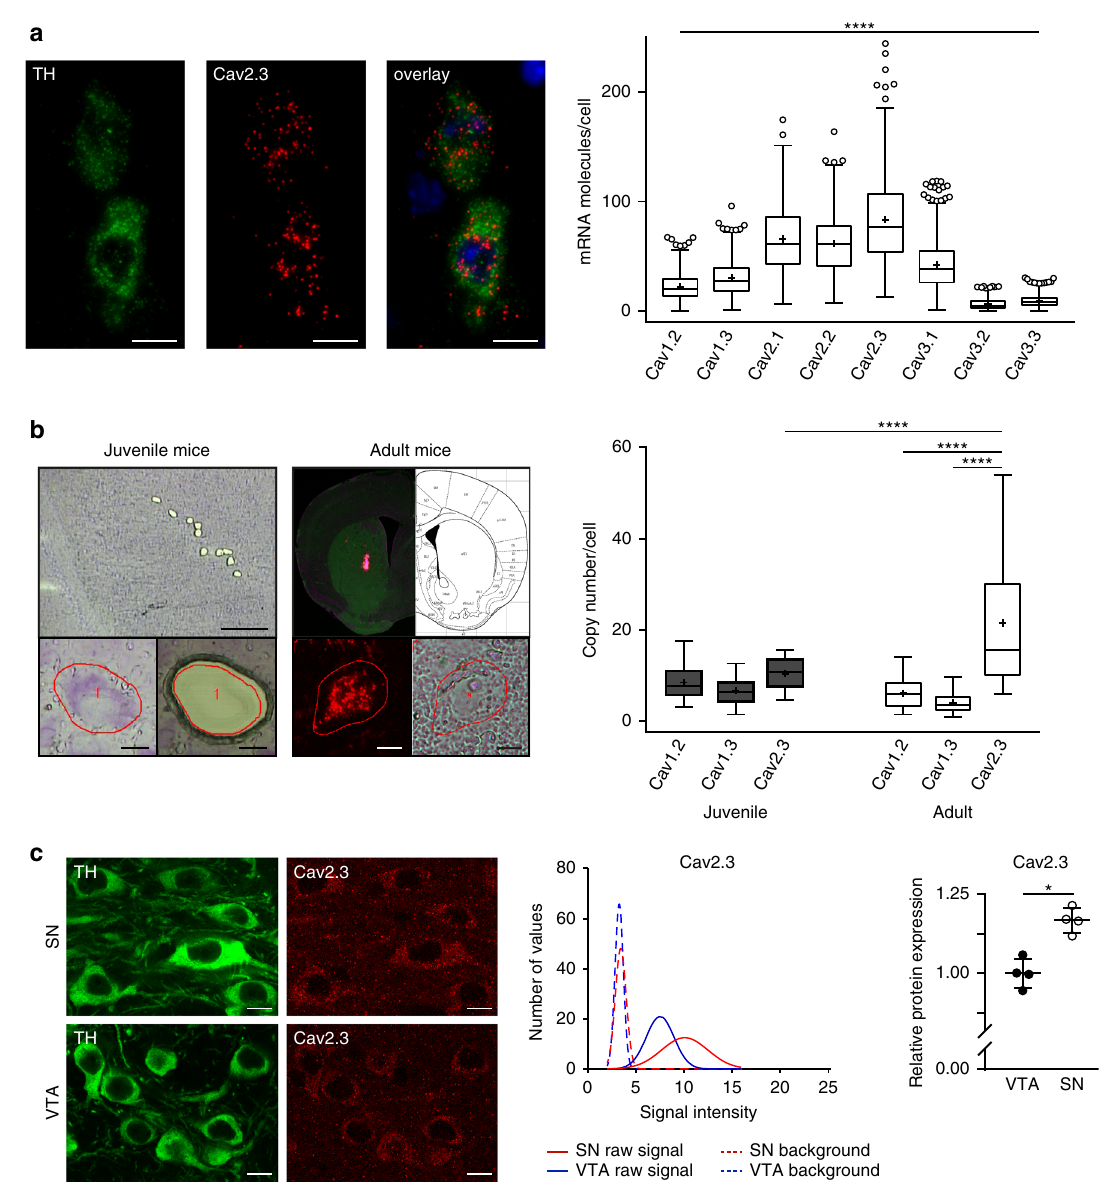
Fig. 1 Cav2.3 is abundantly expressed in mature SN dopaminergic neurons. a Left: Representative images showing Cav2.3 (red) and tyrosine hydroxylase (TH; green) RNAScope fl uorescence signals (combined with nuclear DAPI staining, blue) of individual SN dopaminergic neurons from an adult wildtype mouse. Scale bar: 10 µ m. Right: Absolute mRNA transcript numbers per cell in adult SN dopaminergic neurons for distinct voltage-gated Ca 2 + channel α -subunits, as indicated (Cav1.2: n = 667, Cav1.3: n = 537, Cav2.1: n = 425, Cav2.2: n = 461, Cav2.3: n = 435, Cav3.1: n = 657, Cav3.2: n = 573, Cav3.3: n = 498). b Left: Juvenile and adult mouse brain sections before and after UV-laser microdissection, in bright fi eld and fl uorescent mode, respectively, and striatal injection site documentation of an in vivo retrogradely traced adult mouse, aligned with the mouse brain atlas. Scale bars: 250 µ m and 10 µ m, respectively. Right: Cell-speci fi c UV-laser microdissection and reverse transcription quantitative PCR-based transcript molecule quanti fi cation in single mouse SN dopaminergic neurons upon aging for Cav1.2 # (juvenile: n = 26; adult: n = 25), Cav1.3 # (juvenile: n = 24; adult: n = 24) ( # data partly modi fi ed from ref. 37 ), and Cav2.3 (juvenile: n = 13; adult: n = 27). c Left: Confocal images showing Cav2.3 antibody staining (red) of TH-positive (green) neurons in SN and VTA of an adult wildtype mouse, respectively. Scale bar: 10 µ m. Middle: Histogram showing the immunosignal intensity distributions of plasma membrane Cav2.3 signal, and respective background signal intensities for all analyzed TH-positive SN (red) and VTA (blue) neurons, exemplary of one C57BL/6J mouse (SN: n = 145; VTA: n = 128). Right: Mean Cav2.3 immunosignal quanti fi cation in SN and VTA dopaminergic neurons for all analyzed mice ( n = 4). Antibody speci fi city was con fi rmed on Cav2.3 knockout mice. Tukey's box plots are shown. Signi fi cances are indicated by asterisks: * p <0.05, ** p <0.01, *** p <0.001, **** p <0.0001. All data are detailed in Supplementary Tables 1, 4A, 5A/B and Supplementary Fig. 6. Source data are available as a Source Data fi